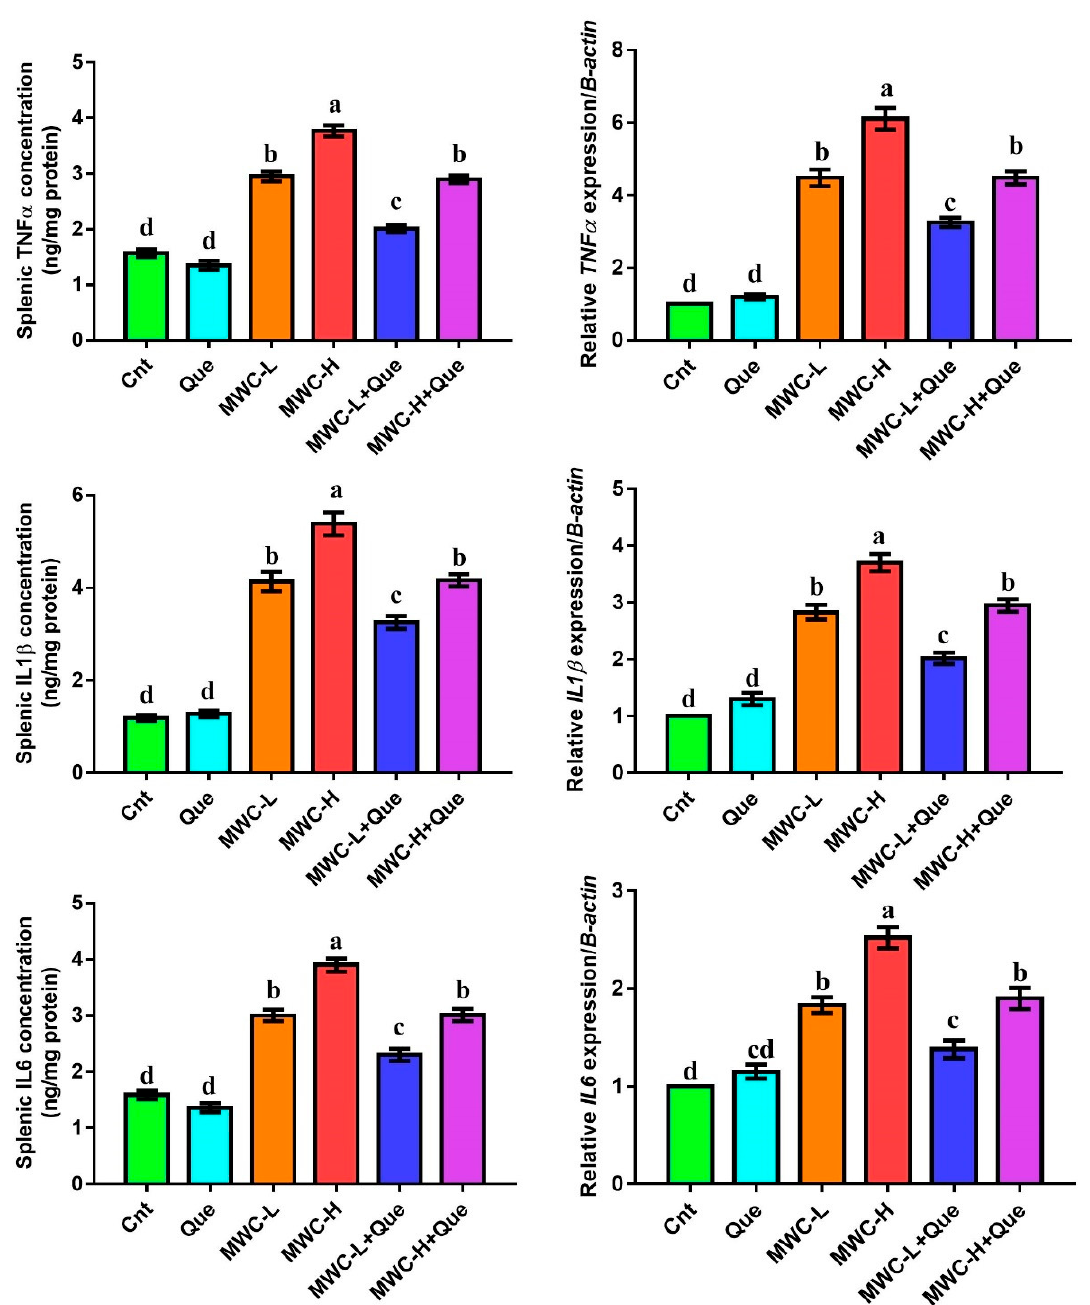
Figure 3. Effect of MWCNTs and/or quercetin on splenic inflammatory cytokines (TNF α , IL1 β , IL6) as detected by Elisa (concentration) and qPCR (gene expression). Data represent three independent experiments and were presented as mean ± SEM (n = 5/group). Means within columns carrying different letters are significantly different at p ≤ 0.05. All groups were compared to each other. Cnt, control group; Que, quercetin-treated group; MWC-L, MWCNTs low dose-treated group; MWC-H, MWCNTs high dose-treated group; MWC-L+Que, MWCNTs low-dose and quercetin co-treated group; MWC-H+Que, MWCNTs high-dose and quercetin co-treated